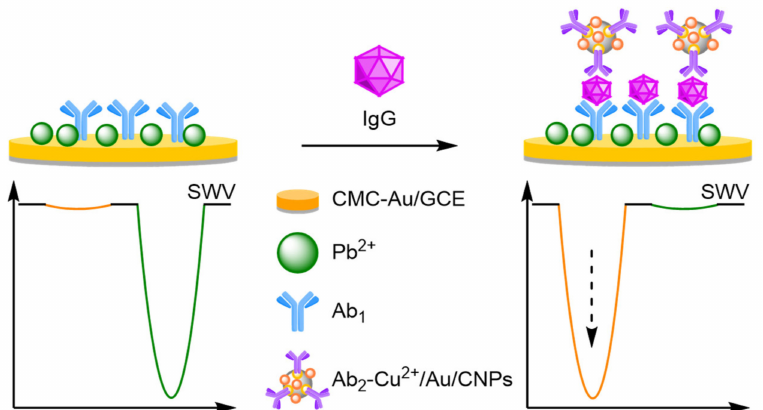
Figure 36. Schematic representation of an antibody-based modified electrode for the detection of immunoglobulin G